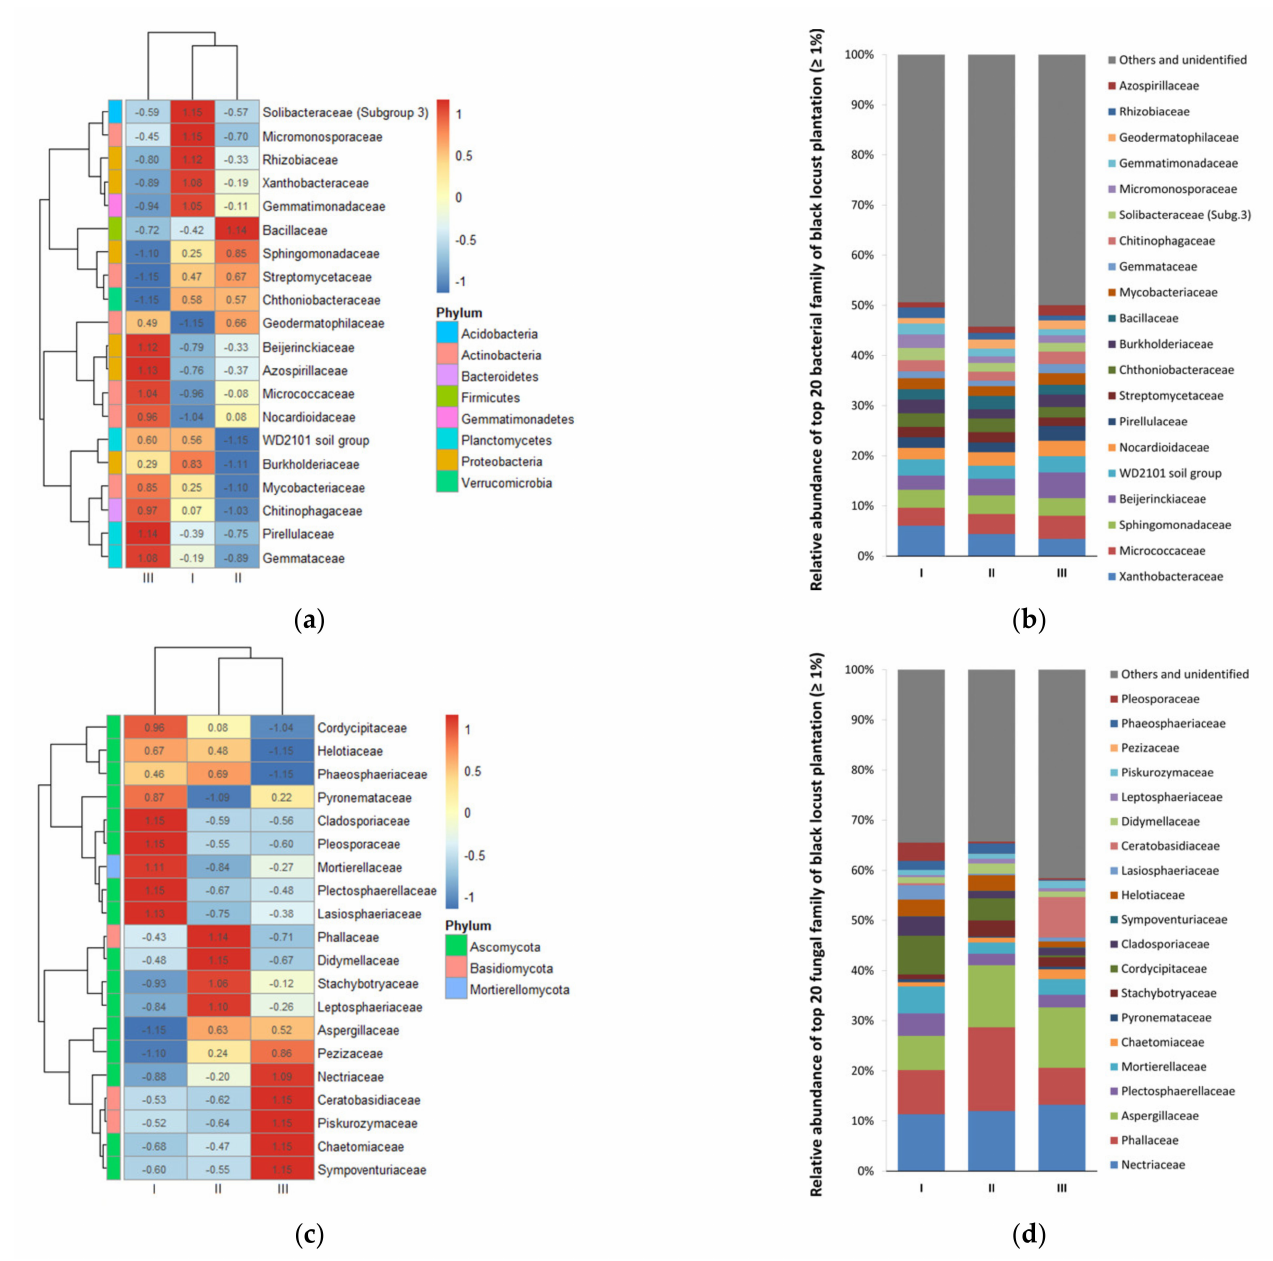
Figure 5. Relative abundance by the corresponding z-score of top 20 bacterial ( a ) and fungal ( c ) family; relative abundance (%) of top 20 bacterial ( b ) and fungal ( d ) families in rhizosphere soil of black locust plantation by treatments; control (I), fertilizer (II) and arbuscular mycorrhizal (III)